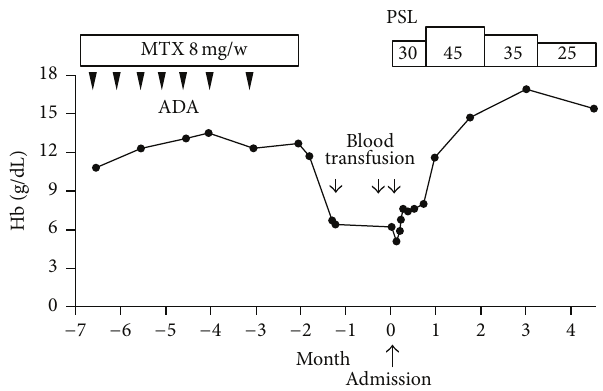
Figure 1: Clinical course of the patient and hemoglobin levels. ADA: adalimumab; Hb: hemoglobin; MTX: methotrexate; PSL: prednisolone